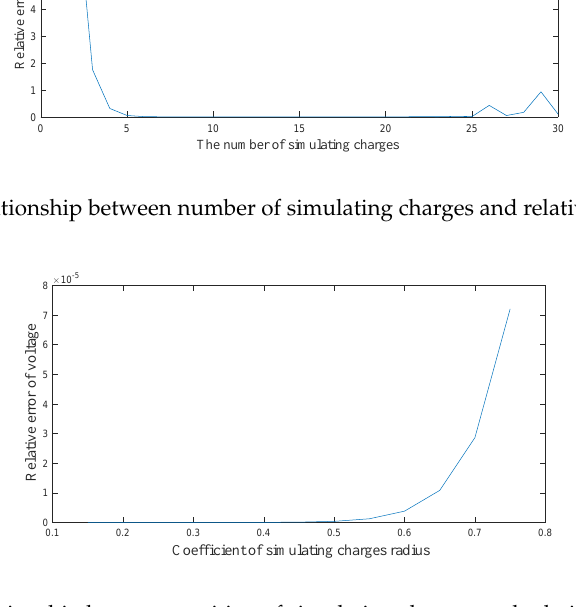
Figure 12. The relationship between position of simulating charges and relative error of voltage.